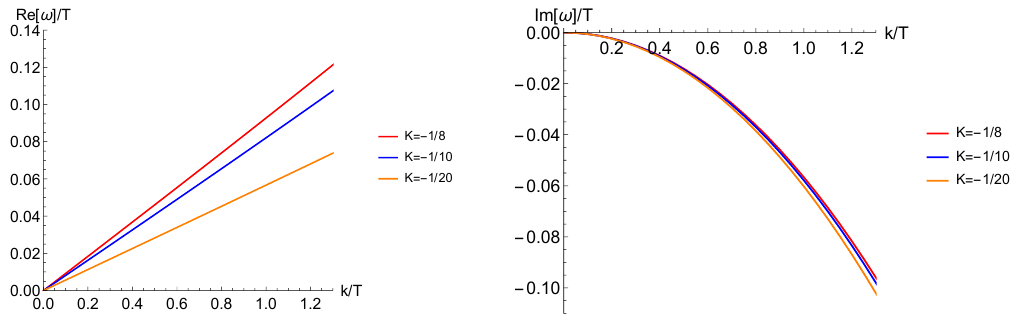
Figure 2 . Real and imaginary parts of the lowest QNMs for different temperatures. We have fixed coupling K = − 1 / 8 and λ = 0 . We try to use the generalized dispersion relation ω = c fit the QNMs data. In our numerical cases, we get a = 1 . 00003 ± 0 . 00002 and b = 2 . 00003 ± 0 . 00003 , which satisfies the dispersion relation (3.1).